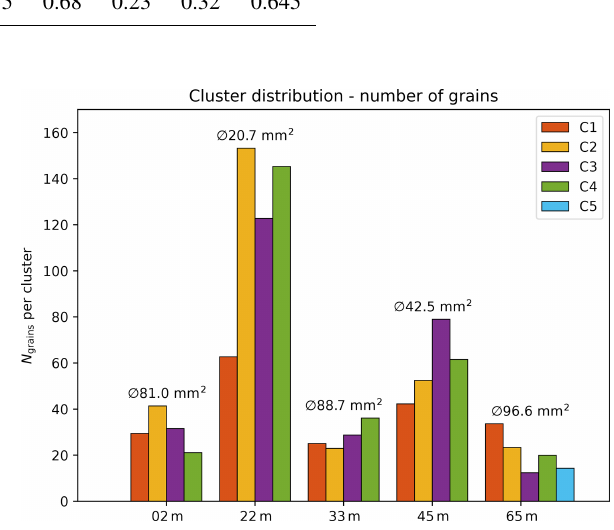
Figure 6. Number of grains over all clusters in the individual sam- ples. The mean grain size (cid:11) per sample is noted above. The clusters are colour-coded according to Fig.